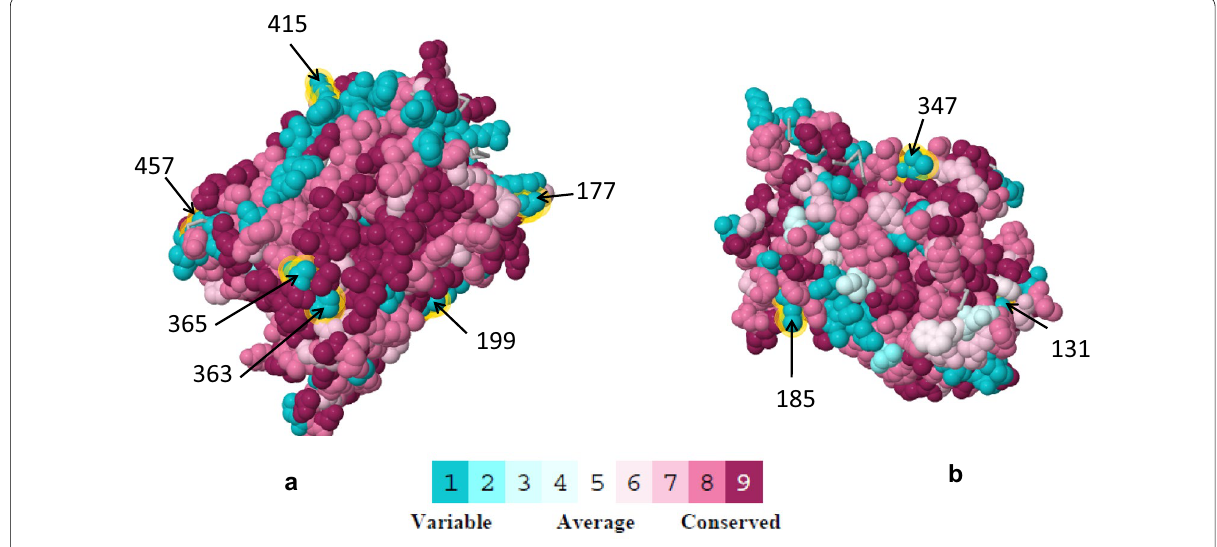
Fig. 2 Topology and structure of the B. taurus superimposed with the multiple sequence alignment (MSA) of COX1 ( a ), COX3 ( b ), and CYTB ( c ) OXPHOS genes. The amino acids of the monomer are colored by their conservation grades using the color-coding bar, with turquoise through maroon, indicating variable through conserved amino acid positions. Amino acids under positive selection are also indicated